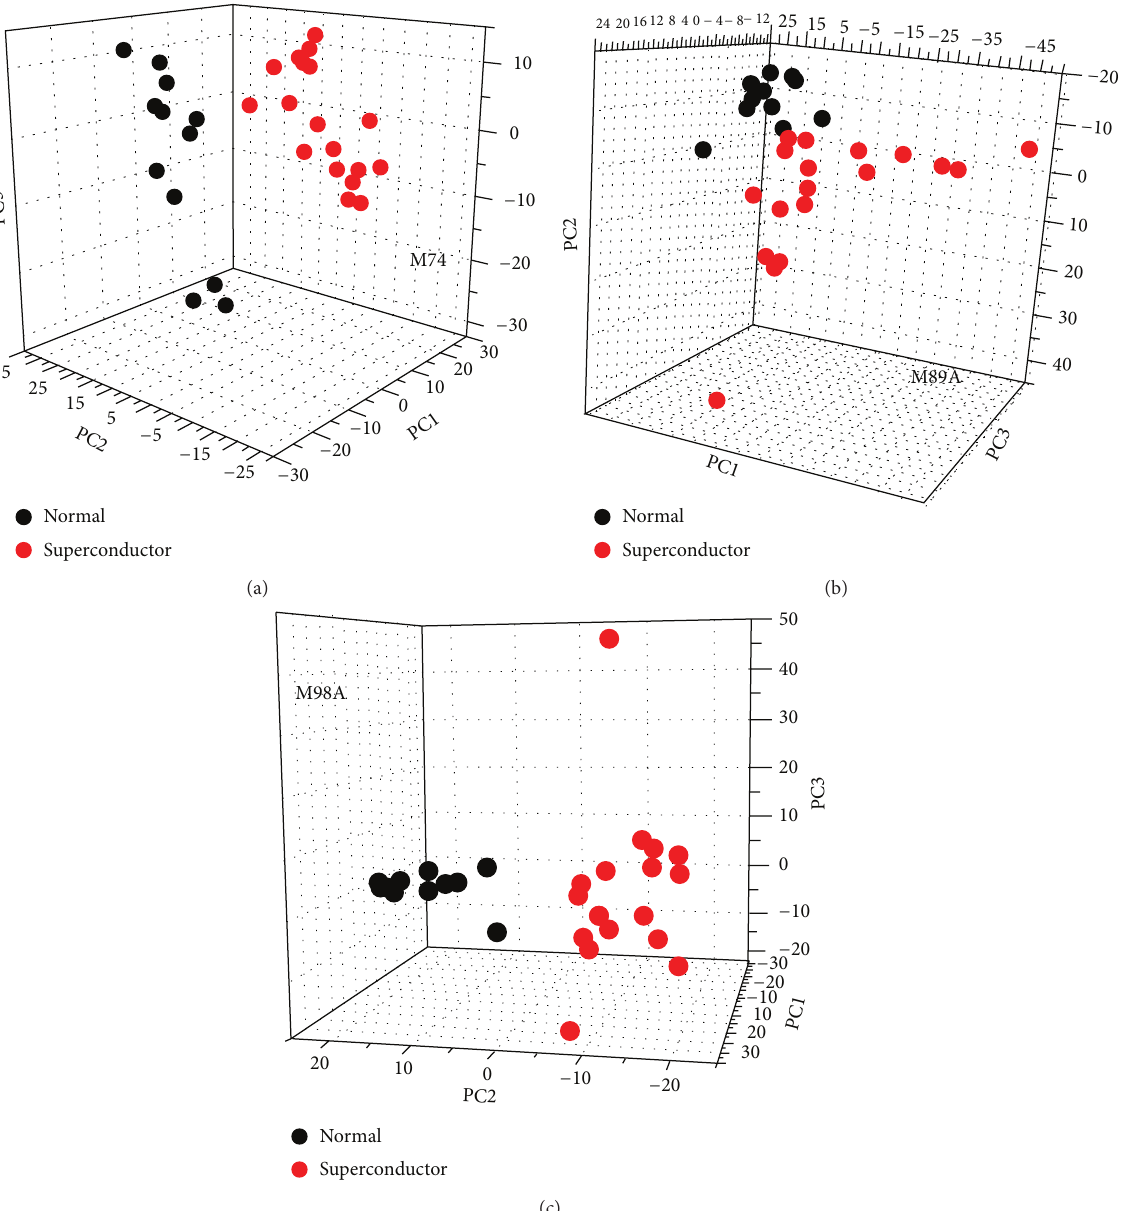
Figure 3: Scatter plot of all temperature-dependent Raman spectra for three TlBa 2 Ca 2 Cu 3 O 9 high- 𝑇 𝐶 superconductor films with Tl-1223